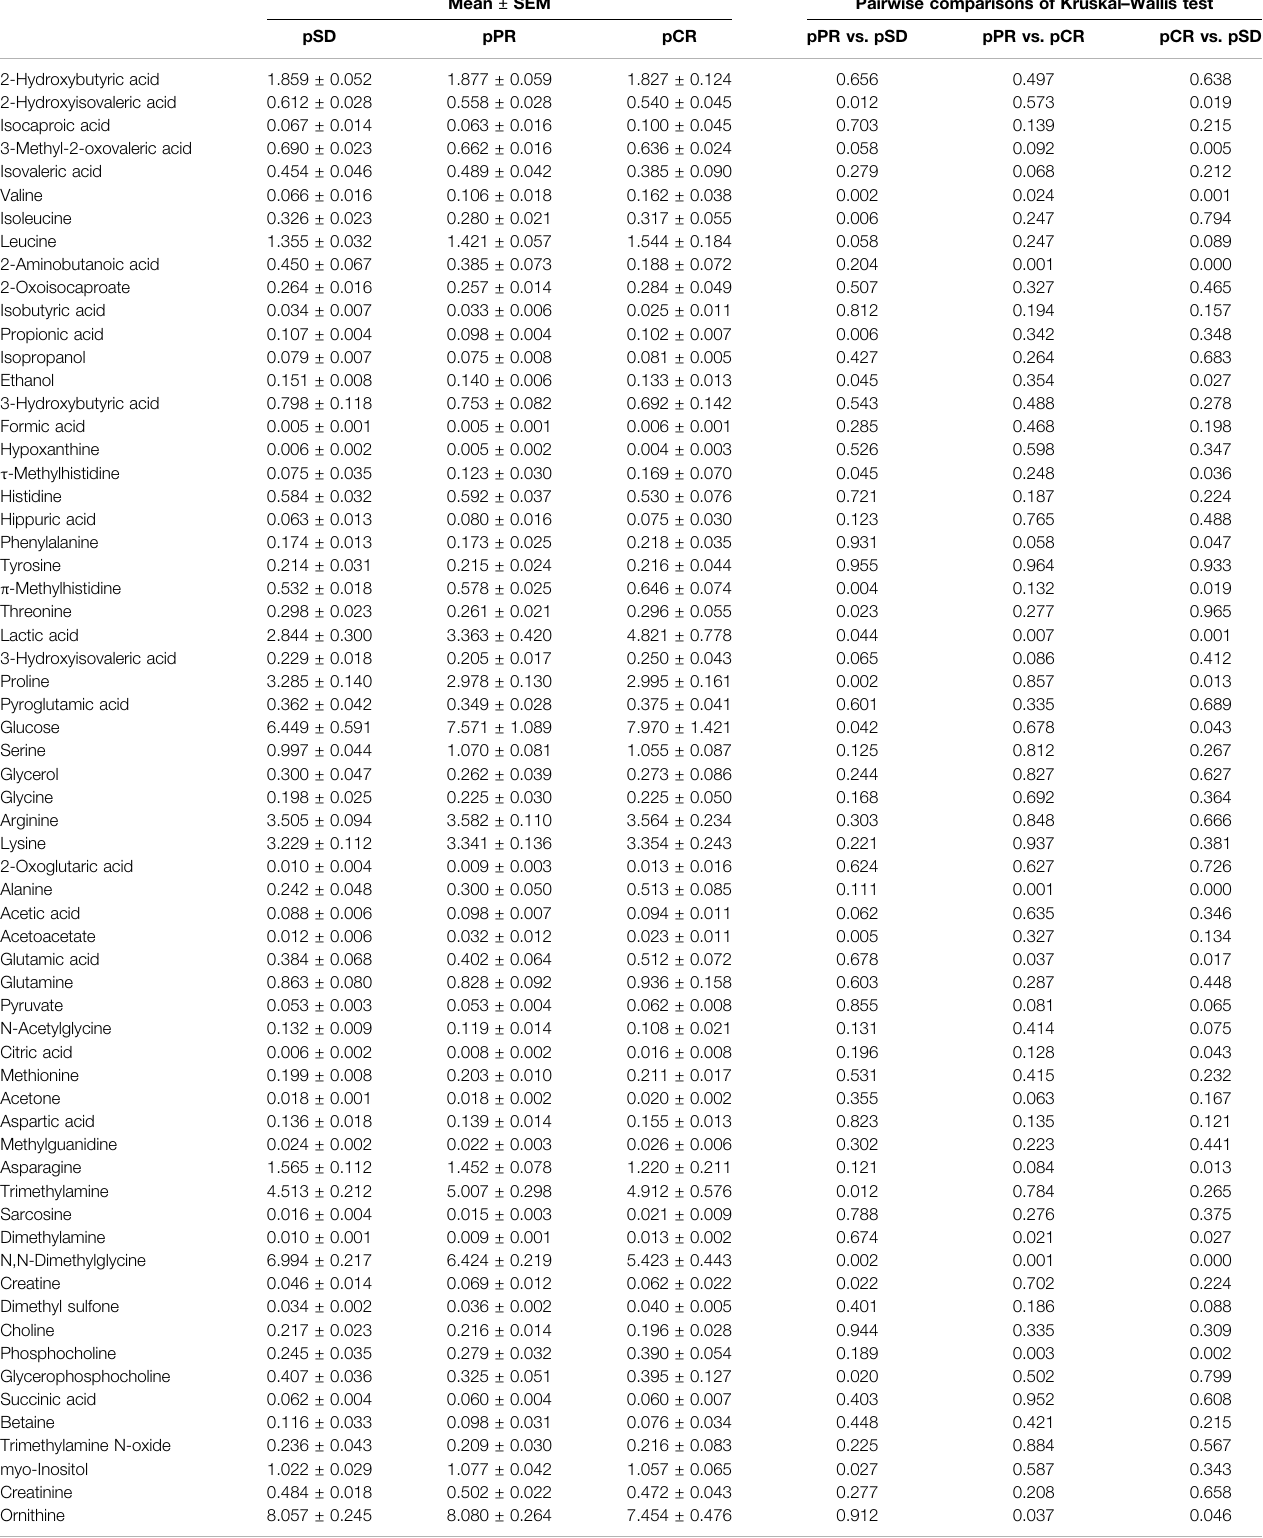
TABLE 1 | Comparison of metabolite levels among the three groups on relative integrals calculated from 1D 1 H-NMR spectra of TNBC patients ’ serum samples. Mean ± SEM Pairwise comparisons of Kruskal – Wallis test pSD pPR pCR pPR vs. pSD pPR vs. pCR pCR vs.